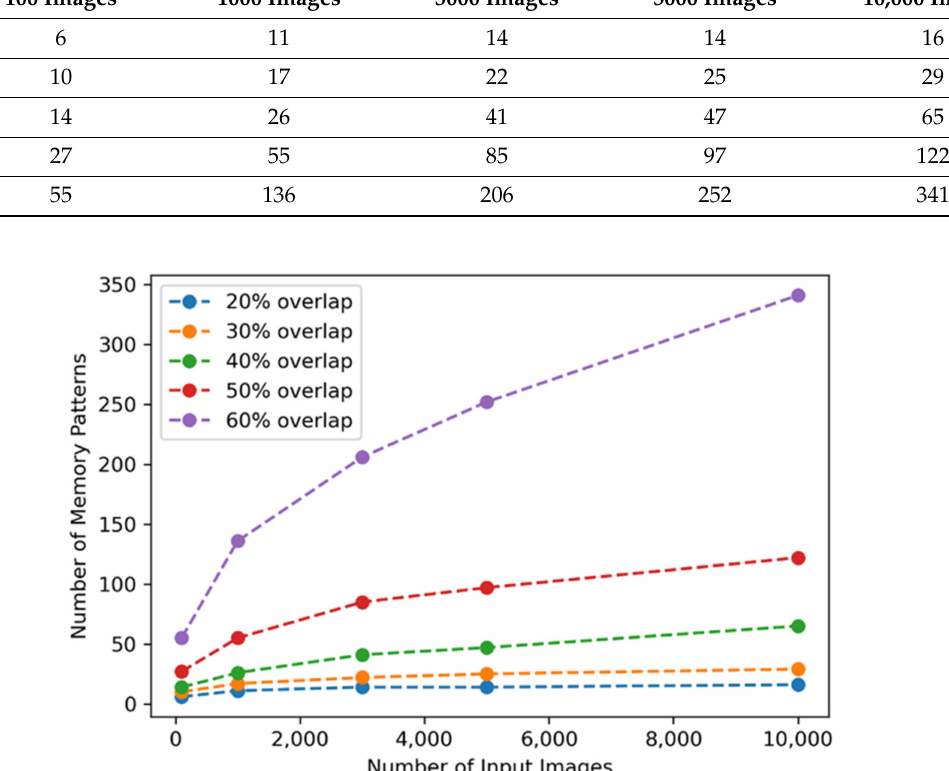
Figure 16. Number of memory patterns according to SDR overlapping ratio and number of input images without pre-memory